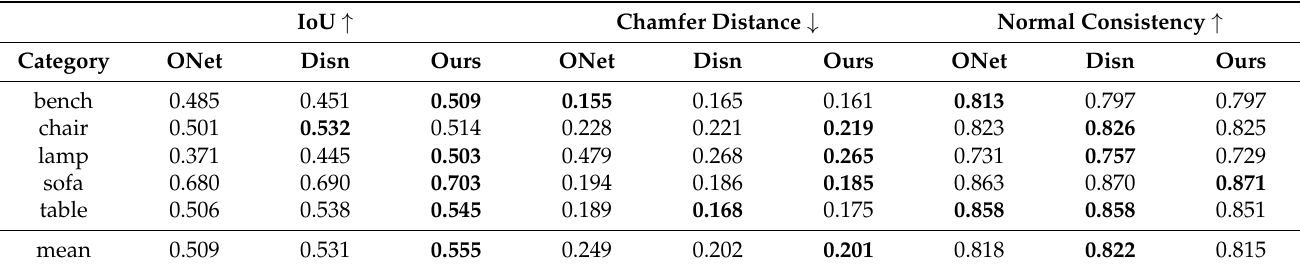
Table 3. Comparison of reconstruction